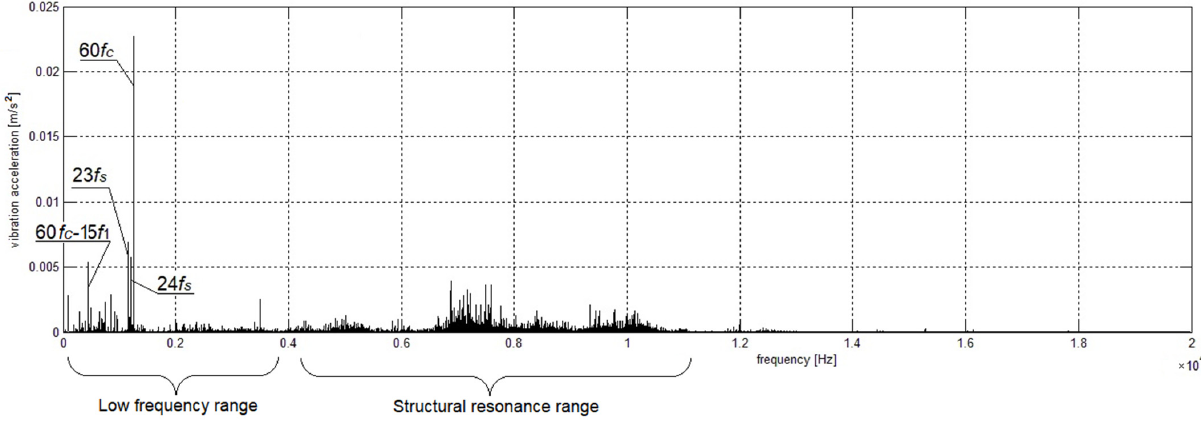
Figure 6. Frequency spectrum of vibration acceleration of the outer casing of the motor with a damaged bearing cage. The dominant frequency components of vibrations are marked.